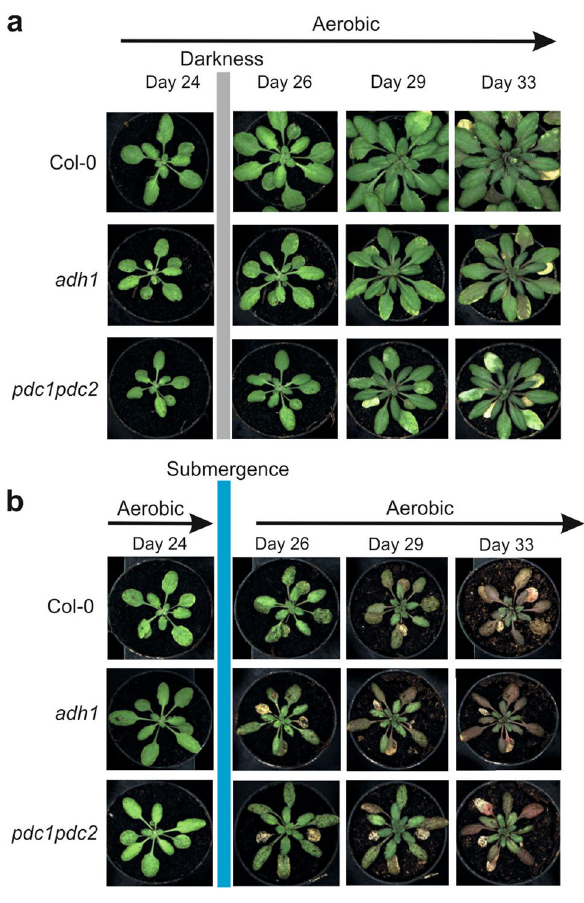
Figure 5. Effect of submergence on the phenotype of Arabidopsis plants. Plants were grown under aerobic conditions for 24 days and then transferred to submergence for 35 h. Plants were then transferred back to aerobic conditions. Tanks with a water level of 10 cm above leaf level were used to submerge the plants. ( a ) Plants grown under aerobic conditions for 33 days. ( b ) Plants grown under aerobic conditions for 24 days, and transferred to submergence for 35 h, and back to aerobic conditions until day